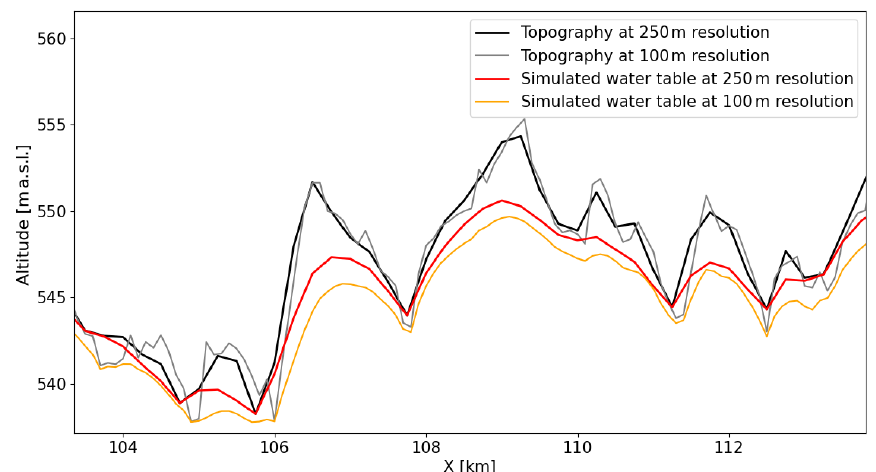
Figure A2. 1D section of topography and the simulated water table in Bhima. Comparison between a groundwater model resolution of 100 and 250m. Note how topography at 100m resolution is below topography at 250m resolution in valleys. The resulting water table appears lower at 100 than at 250m resolution over the whole